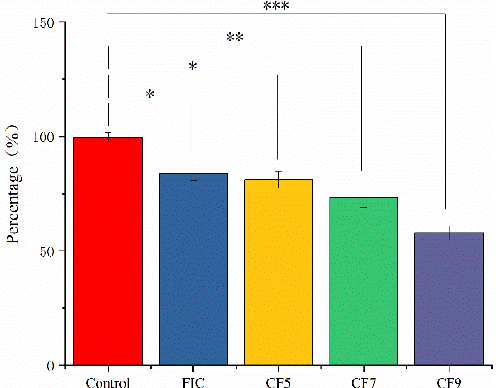
Figure 1. Effects of different treatments on H. pylori 3192 biofilm biomass. Four-day mature H. pylori biofilm was treated with different treatments, and the biomass of the H. pylori biofilm was assessed by 1% crystal violet staining. Control group: BB2, FIC group: 1 × FIC of AMX and CLR, CF5 group: 6.25% CFS of 10 5 CFU/mL L. salivarus LN12 in combination with 1 × FIC of AMX and CLR, CF7 group: 6.25% CFS of 10 7 CFU/mL LN12 in combination with 1 × FIC of AMX and CLR, CF9 group: 6.25% CFS of 10 9 CFU/mL L. salivarus LN12 in combination with 1 × FIC of AMX and CLR. AMX: Amoxicillin, CLR: Clarithromycin. ∗ : p ≤ 0.05, ∗∗ : p ≤ 0.01, and ∗∗∗ : p ≤ 0.001.